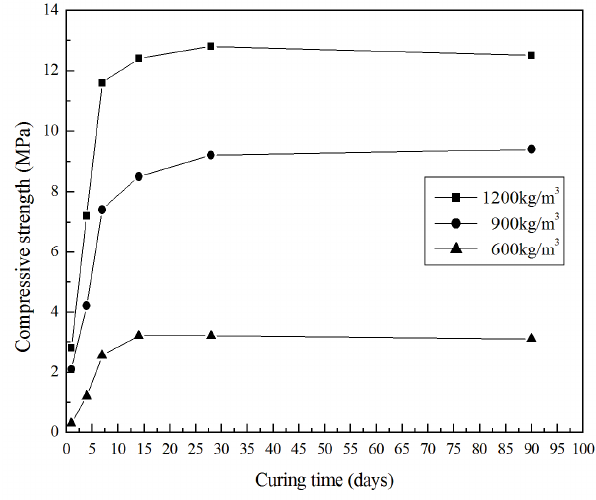
Figure 6. Compressive strength of GLWC vs. curing time.